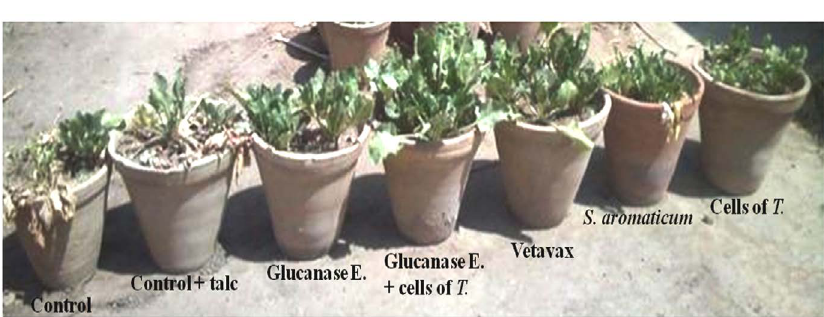
Fig. 2. Effect of different treatments on root rots disease severity of sugar